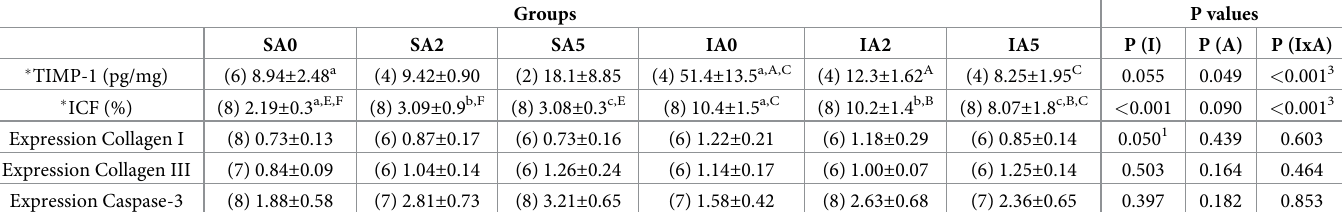
Table 6. Collagen degradation markers and caspase-3.